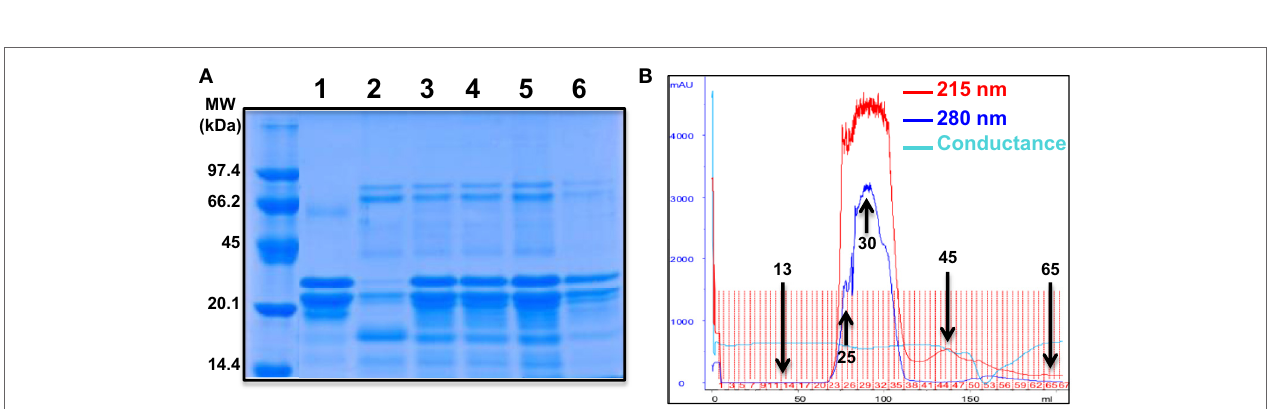
FigUre 4 | camel milk fractionations. (a) The defatted camel milk was fractionated and the resulting fractions were submitted to SDS-PAGE followed by staining with the Coomassie Blue as indicated in Section “Materials and Methods.” The different tracks represent caseins (1) and whey (2) as well as the fractions 25 (3), 30 (4 and 5), and 45 (6) obtained from gel filtration chromatography (B) . For gel filtration chromatography, fresh camel milk was first defatted and passed through Sephadex G-25 column and different proteins and non-protein fractions were eluted according to their absorbance at 215 nm (red graph) and 280 nm (blue graph) and conductance for non-protein fractions (light blue).